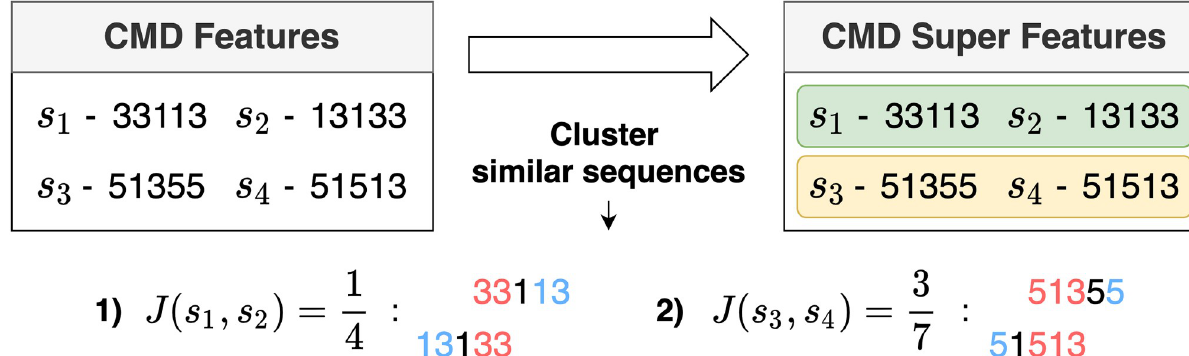
Fig 3. Illustration for generating CMD super features. The first super feature includes sequences s 1 and s 2 , and the second super feature includes sequences s 3 and s 4